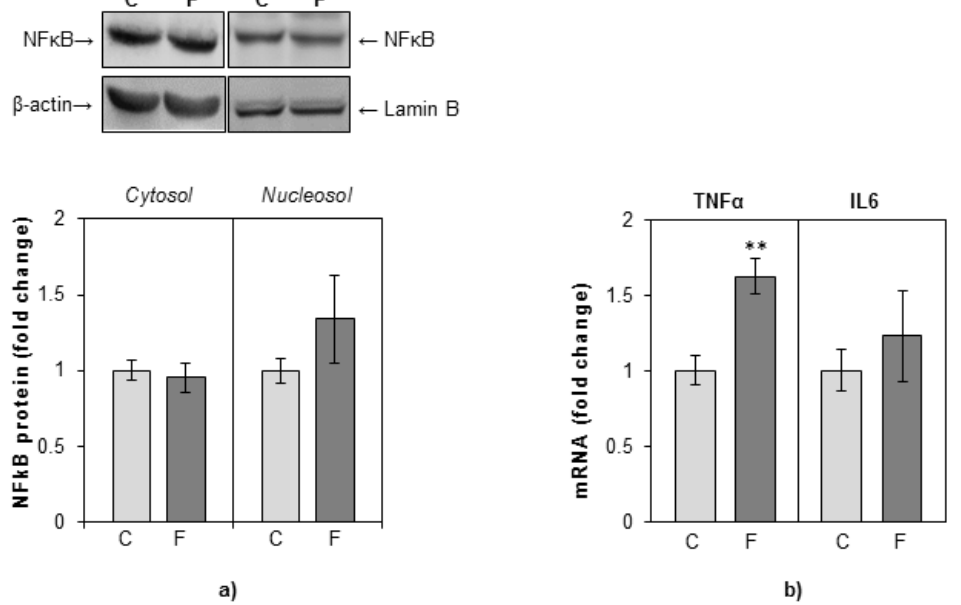
Figure 6. The effects of a fructose-rich diet on the level of NFkB, TNFα, and IL6 in the liver. Groups: control (C), fructose-fed (F). ( a ) NFkB protein level in hepatic cytosols and nucleosols was measured by Western blot. Relative integrated optical density of the immunoreactive bands corresponding to NFkB was assessed by ImageQuant software, normalized to equal load controls, and expressed as fold of the control. ( b ) The level of TNFα and IL6 mRNA relative to HPRT mRNA was determined by TaqMan real-time PCR and expressed as fold of the control. The values represent the means ± SEM ( n = 9). Statistical significance of differences between experimental groups: ** p < 0.01. Table 1. Antioxidant enzyme activities and the level of glutathione (GSH), total thiols (SH), and thiobarbituric acid reactive substances (TBARS) in the liver of female rats subjected to a fructose-rich diet over a period from weaning to adulthood. SOD1, cytoplasmic copper-zinc superoxide dismutase; SOD2, mitochondrial manganese superoxide dismutase: CAT, catalase; GSH-Px, glutathione peroxidase; GSH-Red, glutathione reductase.